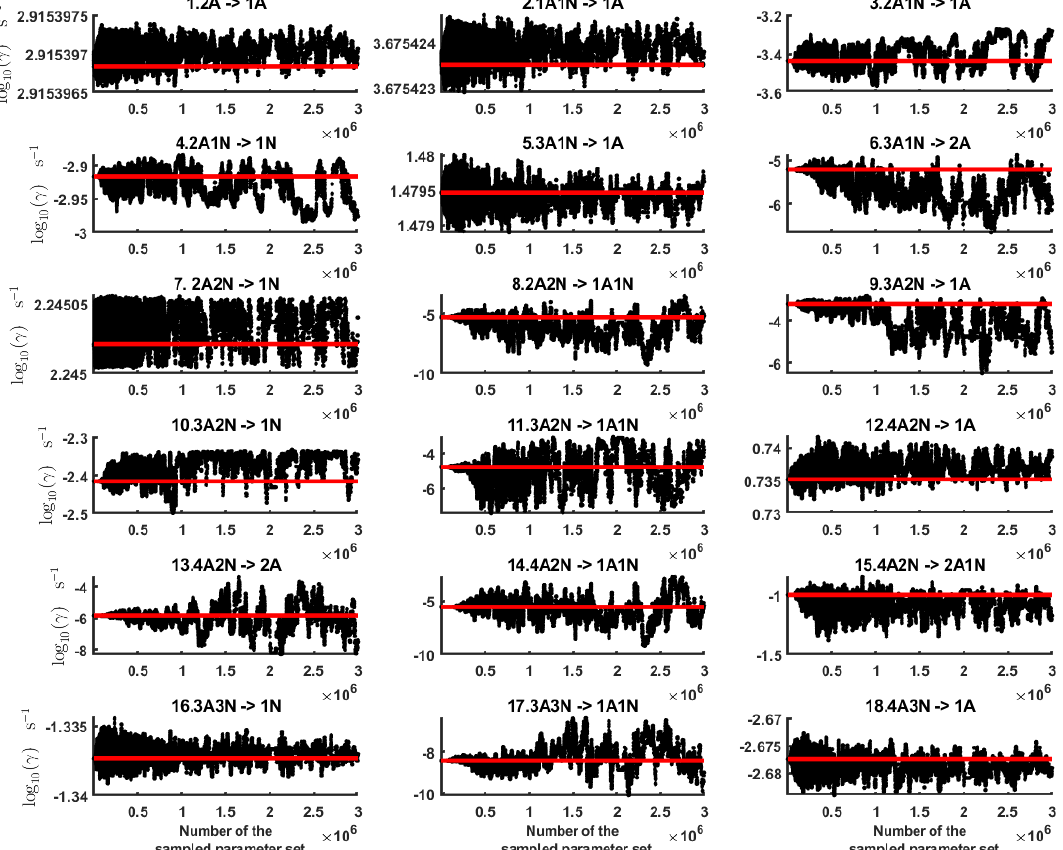
Figure C2. Parameter chains (for parameter indexes ranging from 1 to 28) of the base 10 logarithm of the evaporation rates (units given in s − 1 ) determined from time-dependent measurements of the cluster concentrations with time resolution comprising 1.5min at the temperature 278K. Red lines denote the baseline values from Olenius et al. (2013b) used to generate the synthetic data. The notation xAyN corresponds to a cluster with x sulfuric acid and y ammonia